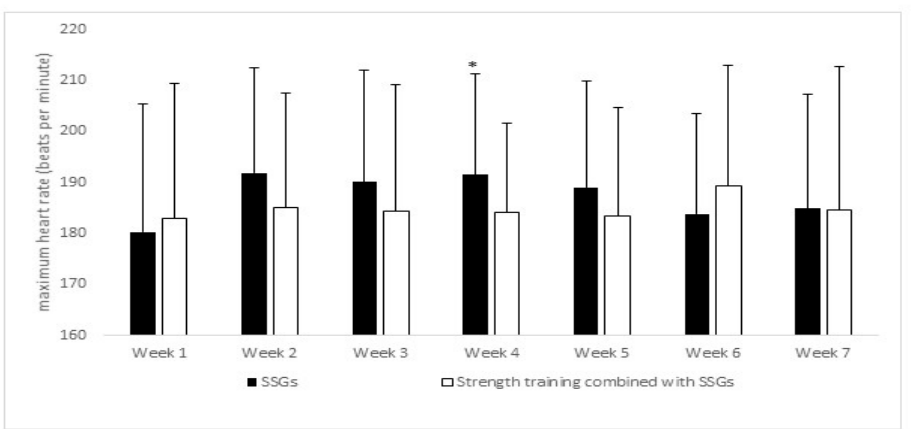
Figure 2. Heart rate activity by weeks (minimum, medium, and maximum). * denotes p < 0.05 differences. Int. J. Environ. Res. Public Health 2021 , 18 , x On the other hand, the external load variables were analysed. Figure 3 shows signif- icant differences between SSGs and the strength training program combined with SSGs in weeks one to five. The variable of velocity by weeks shows significant differences in SSGs compared with the strength training program combined with SSGs in weeks one to six.